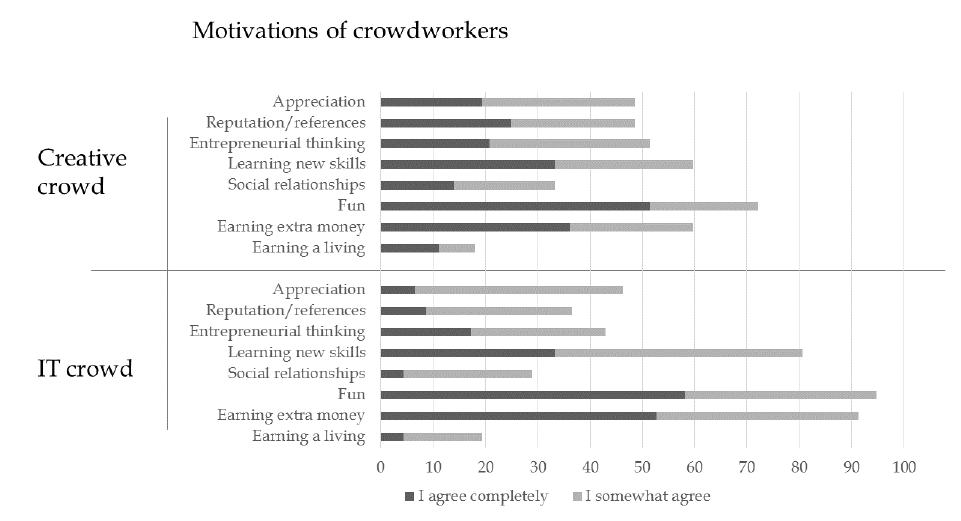
Figure 3: Motivations of the crowdworkers (in percent): the scaling of the response options ranges from “I agree completely” to “I strongly disagree” (1–4). The chart shows the cumulative responses “I agree completely” and “I somewhat